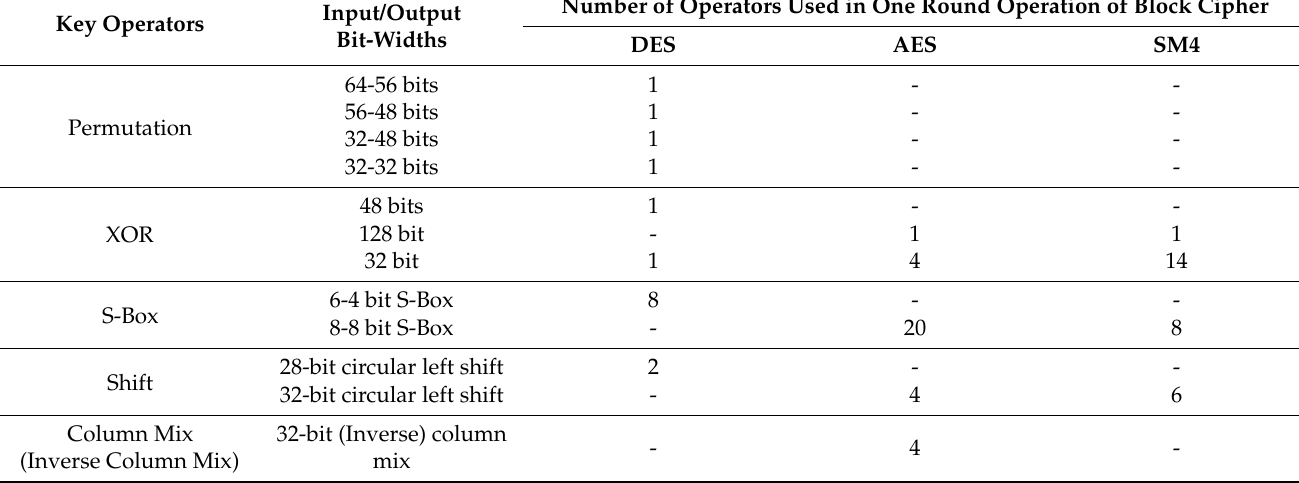
Table 3. Detailed information on key operators of round operations in the three major block